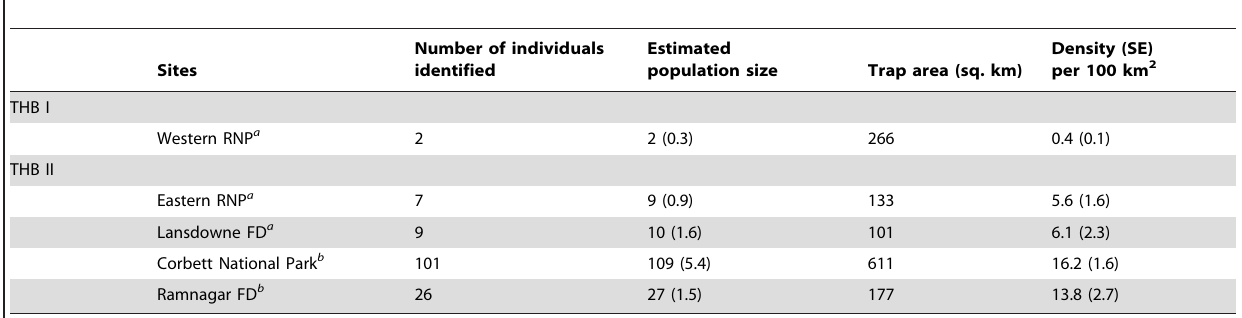
Table 1. Summary of population sizes estimated from camera-trapping studies conducted in the western TAL.